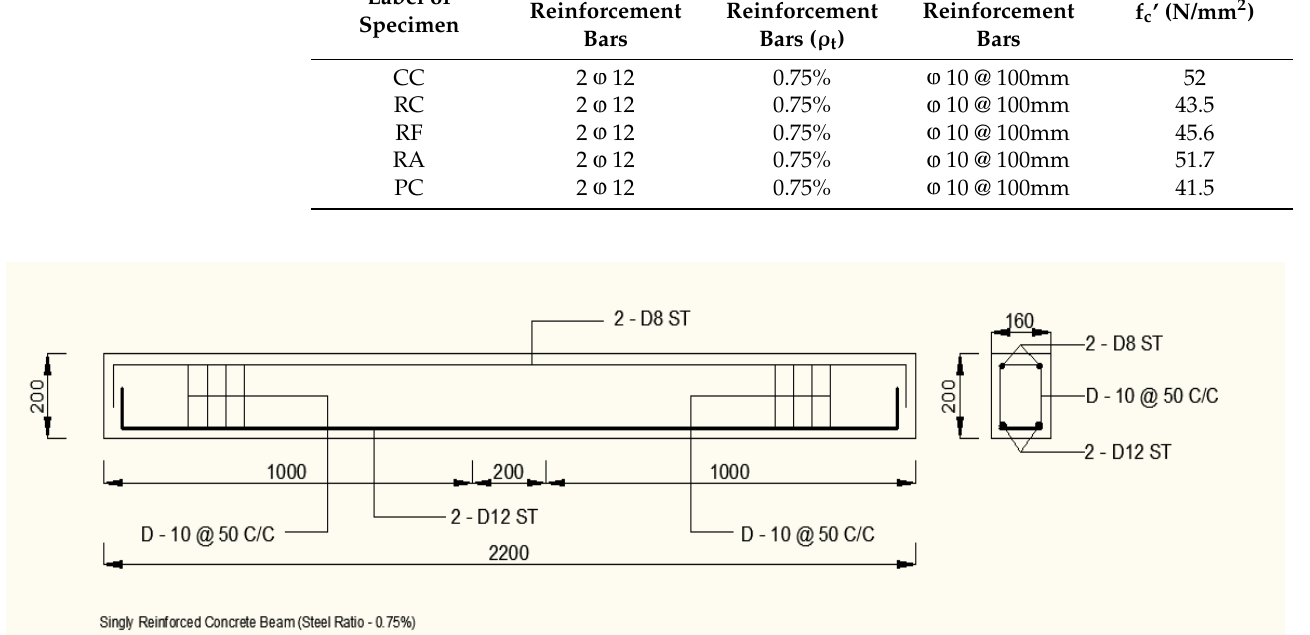
Figure 2. Details geometry of the studied beams.